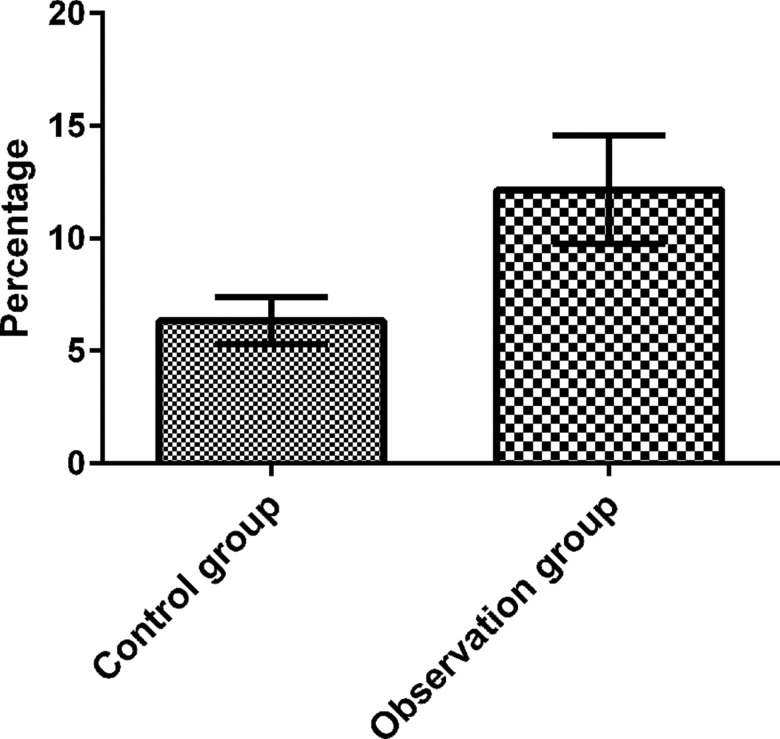
The PBCDT proportions in the observation and control groups. The PBCDT proportion was determined by flow cytometry. The results show that the PBCDT proportion in the peripheral blood was significantly higher in the observation group than in the control group (t=5.684, p<0.05).